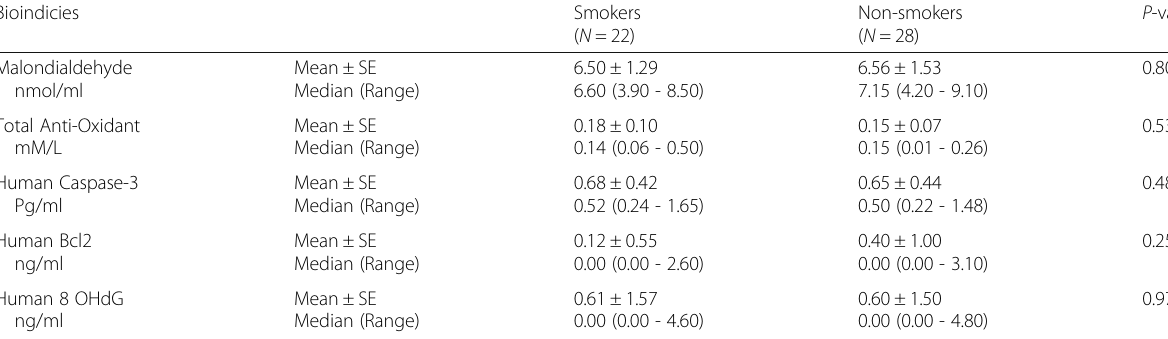
Table 7 Effect of smoking on the biochemical markers in painters Bioindicies Malondialdehyde nmol/ml